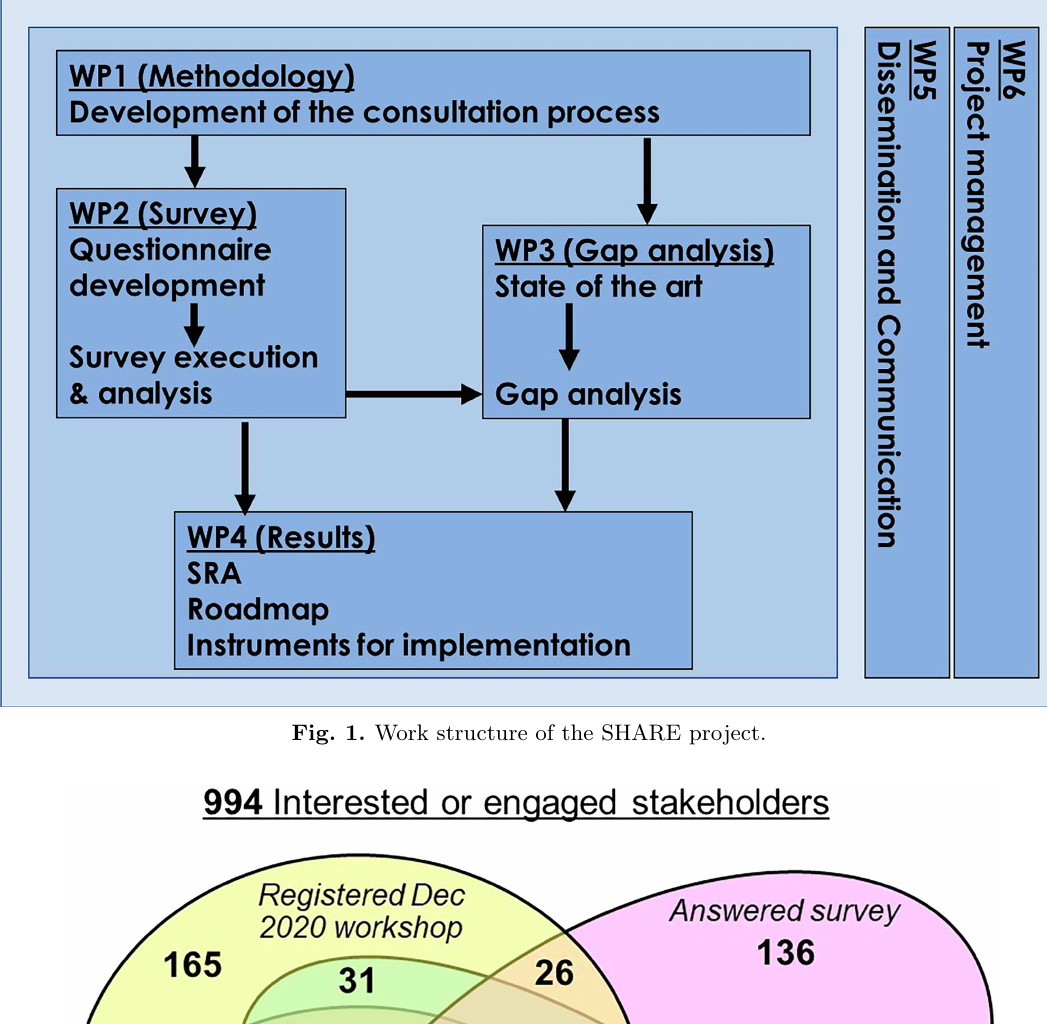
Fig. 1. Work structure of the SHARE project.